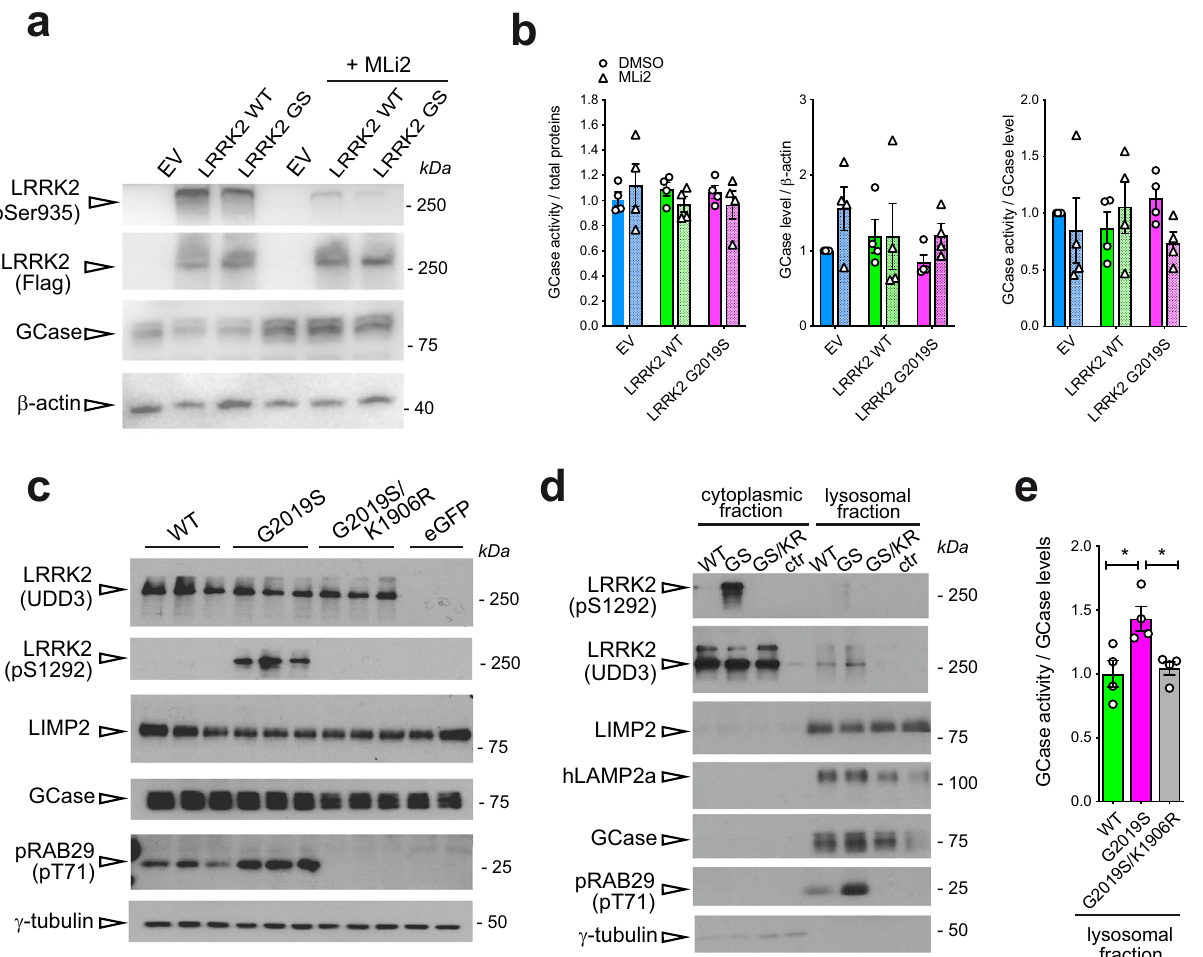
Fig. 5 GCase activity and level is altered in HEK293T cells in which LRRK2 kinase activity is pharmacologically or genetically manipulated. a Representative western blot of LRRK2-Flag, pSer935 LRRK2 and GCase in HEK293 cells overexpressing empty vector (EV), LRRK2 WT and LRRK2 G2019S and treated with the LRRK2 inhibitor MLi2 100 nM for 90 ’ . b From left to right, quanti fi cation of the GCase activity (normalized by total proteins), GCase levels normalized by β -actin and GCase activity normalized by GCase level from western blot. No signi fi cant differences across tratments and genotypes (Two-way ANOVA; data are expressed as mean ± SEM). c Representative western blot of HEK293T cells over-expressing WT, G2019S, or G2019S/K1906R (kinase-dead) LRRK2 probed for total (UDD3) and phosphorylated (pS1292- LRRK2) LRRK2, LIMP1, GCase, phosphorylated Rab29 (T71), and γ -tubulin. LRRK2 kinase function, increased autophosphrylation and phosphorylation of endogenous Rab29 in cells expressing G2019S-LRRK2 is prevented by the kinase inactivating mutation